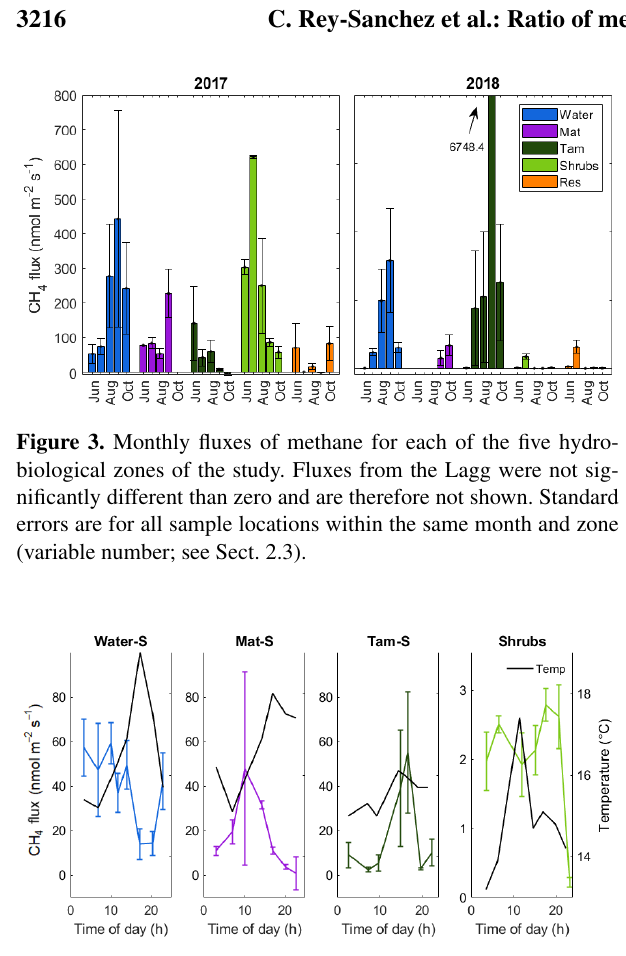
Figure 4. Diurnal patterns of CH 4 emission measured over a 24h period in September 2018. Note a smaller y axis maximum in the Shrubs zone. Error bars represent the standard error of four individ- ual chamber measurements within the same 30min period at each location. Secondary axis (and black lines) shows the temperature at 10cm below the surface either in the open water (Water) or in the peat (Mat, Tamarack, and Shrubs). The Res zone was not sampled.